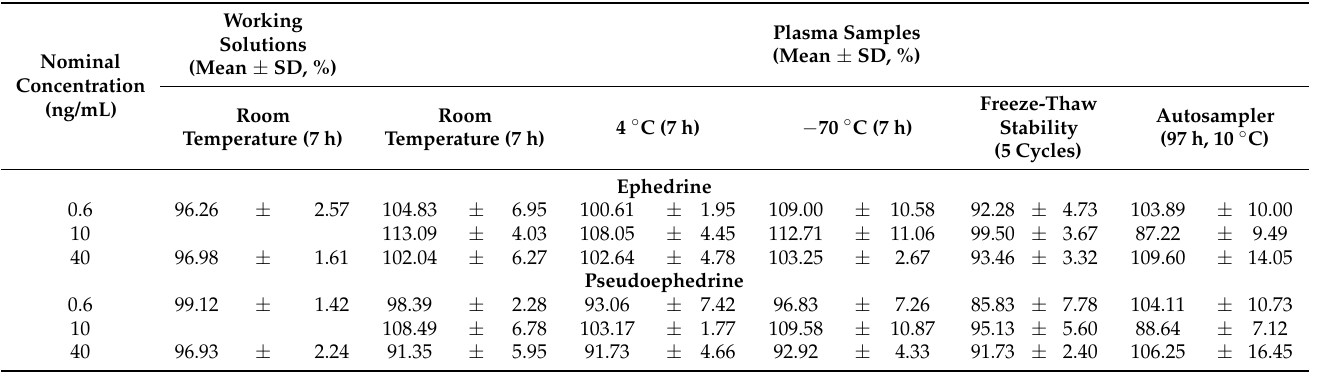
Table 3. Stability data for ephedrine and pseudoephedrine in human plasma samples ( n = 3). Working Nominal Concentration (ng/mL)